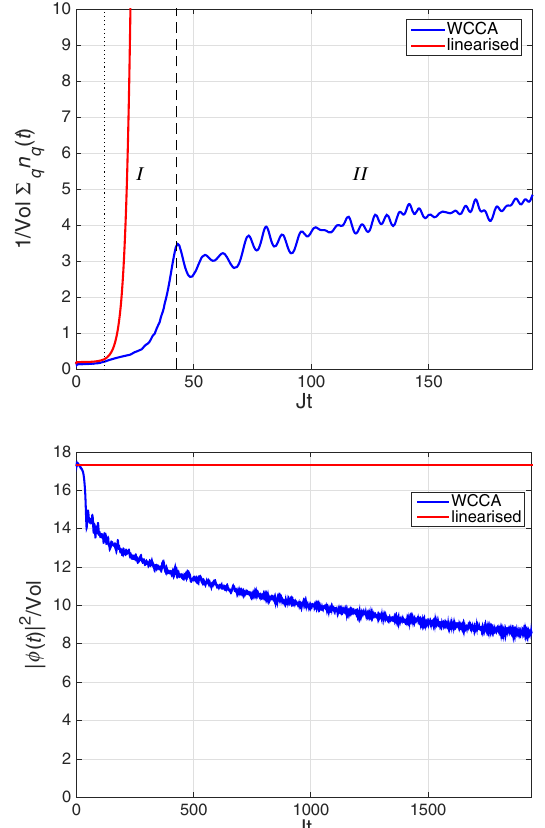
FIG. 16. Time dependence of the quasiparticle (phonon) density (top panel) and the condensate density (bottom panel) using the linearized (red line) and the conserving (blue line) approximation, for the 2D band model from Sec. VI B (with a lattice along the x direction and the continuum along the y direction). There are two discernible regimes: I and II (see text), delineated by a vertical dashed line. The vertical dotted line marks the time up to which the linearized mean-field dynamics and the WCCA agree well. The model parameters are ρ = Vol ¼ 17 . 34 , U=J ¼ 1 . 011 ( g=J ¼ 17 . 53 ), m ¼ 1 = ð 20 J Þ , and healing